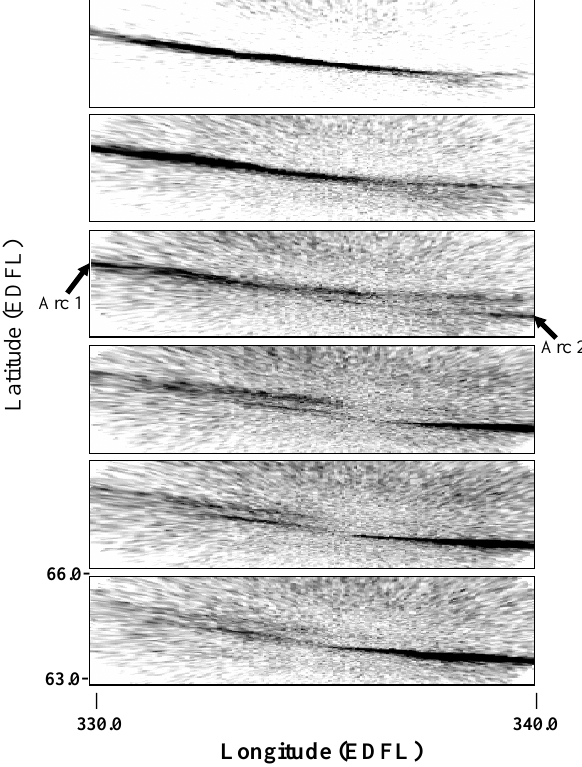
Fig. 7. High passed (0.5mHz) magnetometer data and the Fourier power spectrum for the data at GILL.